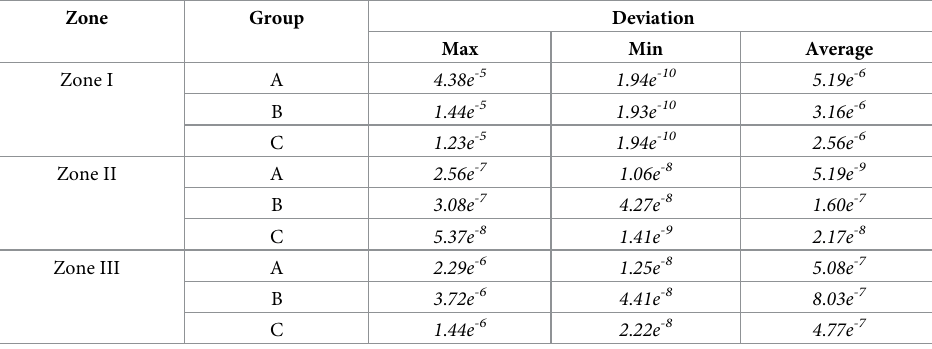
Table 6. The prediction deviation of the prediction